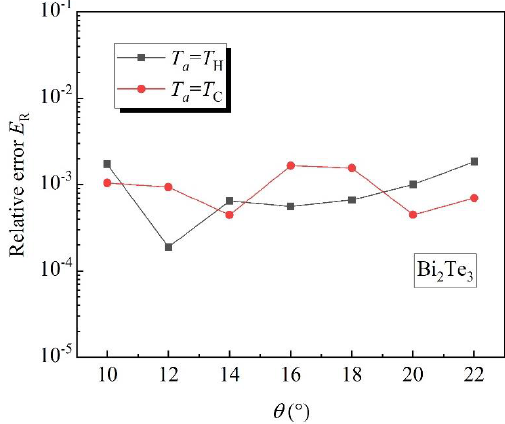
Figure 8. Relative error of explicit analytical and simulated solution after different angles of θ .